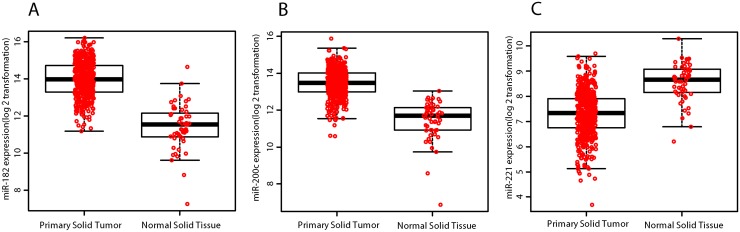
TCGA data for the three differentially expressed miRNAs in prostate primary solid tumor (n = 498) and normal solid tissue (n = 52).(A) The expression levels of miR-182 in prostate primary solid tumor and normal solid tissue. (B) The expression levels of miR-200c in prostate primary solid tumor and normal solid tissue. (C) The expression levels of miR-145 in prostate primary solid tumor and normal solid tissue. The expression level values were calculated using log2 transformed RPM values.